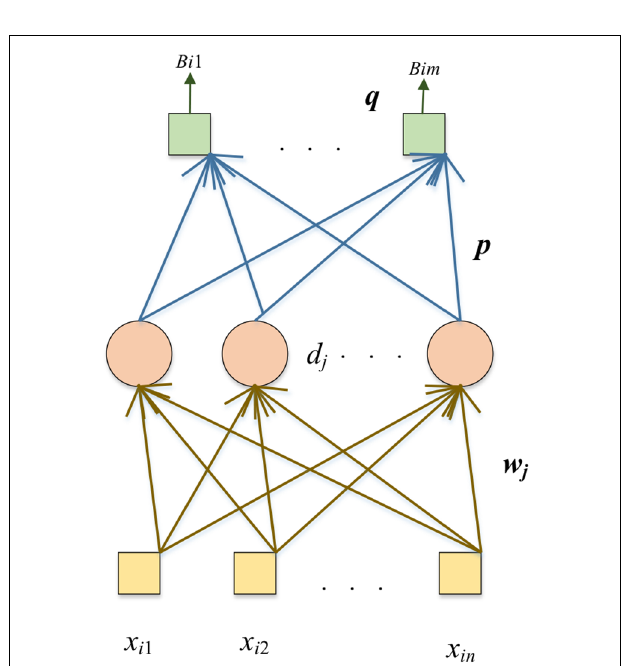
The yellow box represents the input, the pink circle denotes the hidden nodes, and the green box shows the output.